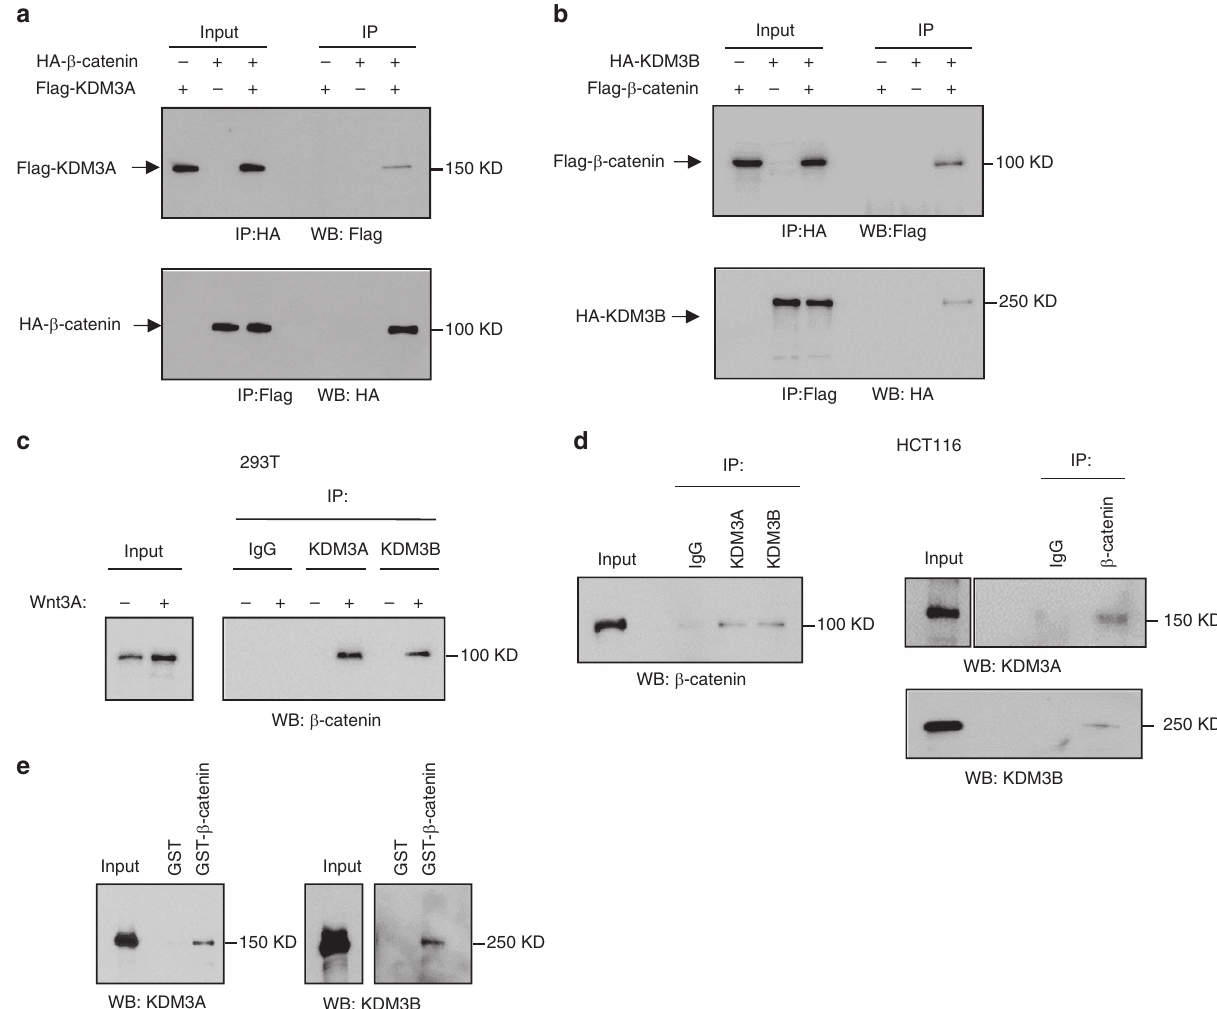
Figure 2 | KDM3A/B interact with b -catenin. ( a , b ) KDM3A and KDM3B interacted with b -catenin when overexpressed in 293 T cells. ( c ) Endogenous b -catenin interacted with KDM3A and KDM3B in 293 T cells on Wnt3a stimulation. ( d ) Endogenous b -catenin interacted with KDM3A and KDM3B in HCT116 cells. ( e ) Glutathione S-transferase fusion b -catenin directly interacted with KDM3A and KDM3B in vitro